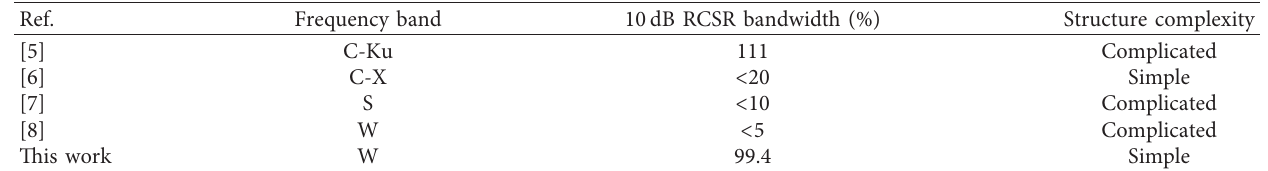
Table 2: Comparison of characteristics with other works.